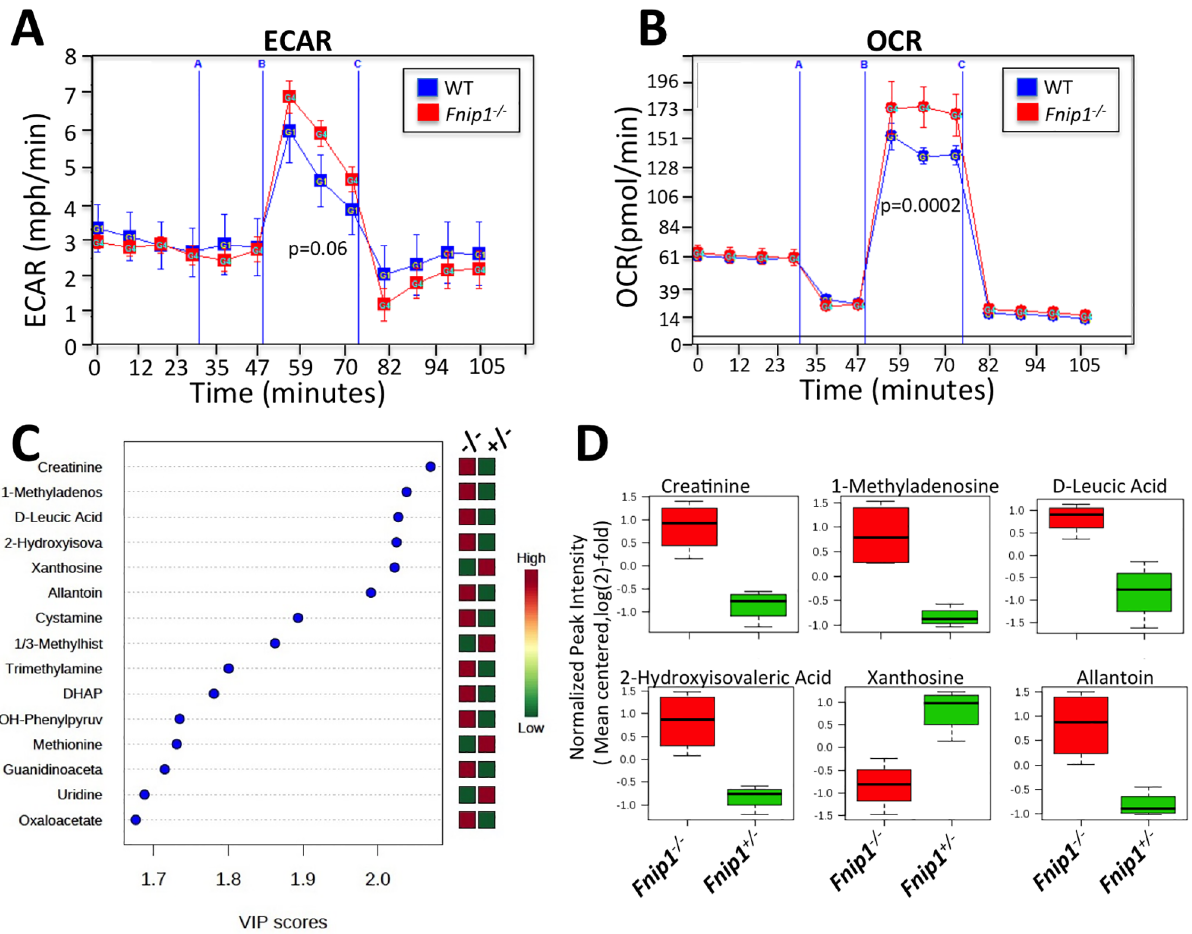
Fig 3. Fnip1 -/- kidney tubular epithelial cells exhibit increased metabolism. (A) Seahorse analyses showing increased maximal extracellular acidification rate (ECAR), a measure of glycolysis, and (B) increased maximal oxidative phosphorylation (OCR) of cultured purified Fnip1 -/- (n = 3 mice) versus WT (n = 3 mice) renal tubular epithelial cells. Cells were stimulated with oligomycin (2.5 μ M) at 30 minutes, FCCP (0.5 μ M) at 50 minutes, and rotenone (2 μ M) and antimycin A (2 μ M) at 75 minutes. p-values are shown. (C and D) Total kidneys from Fnip1 -/- (n = 4) and WT (n = 3) mice (20–32 weeks old) were analyzed by liquid chromatography tandem mass spectrometry (LC-MS/MS) to determine metabolite levels. Data were analyzed using MetaboAnalyst 3.0. Variable importance in projection (VIP) scores of metabolite changes in Fnip1 -/- versus wildtype renal tissue showing changes in nitrogenous waste products, amino acid metabolites, glycolysis, and TCA cycle metabolites. Metabolites that were significantly different and either increased (red) or decreased (green) are shown. (D) Whisker plots showing selected metabolites either significantly increased or decreased in Fnip1 -/- (red) versus Fnip1 +/- (green) kidney tissue. p-values are listed in S1 Table.